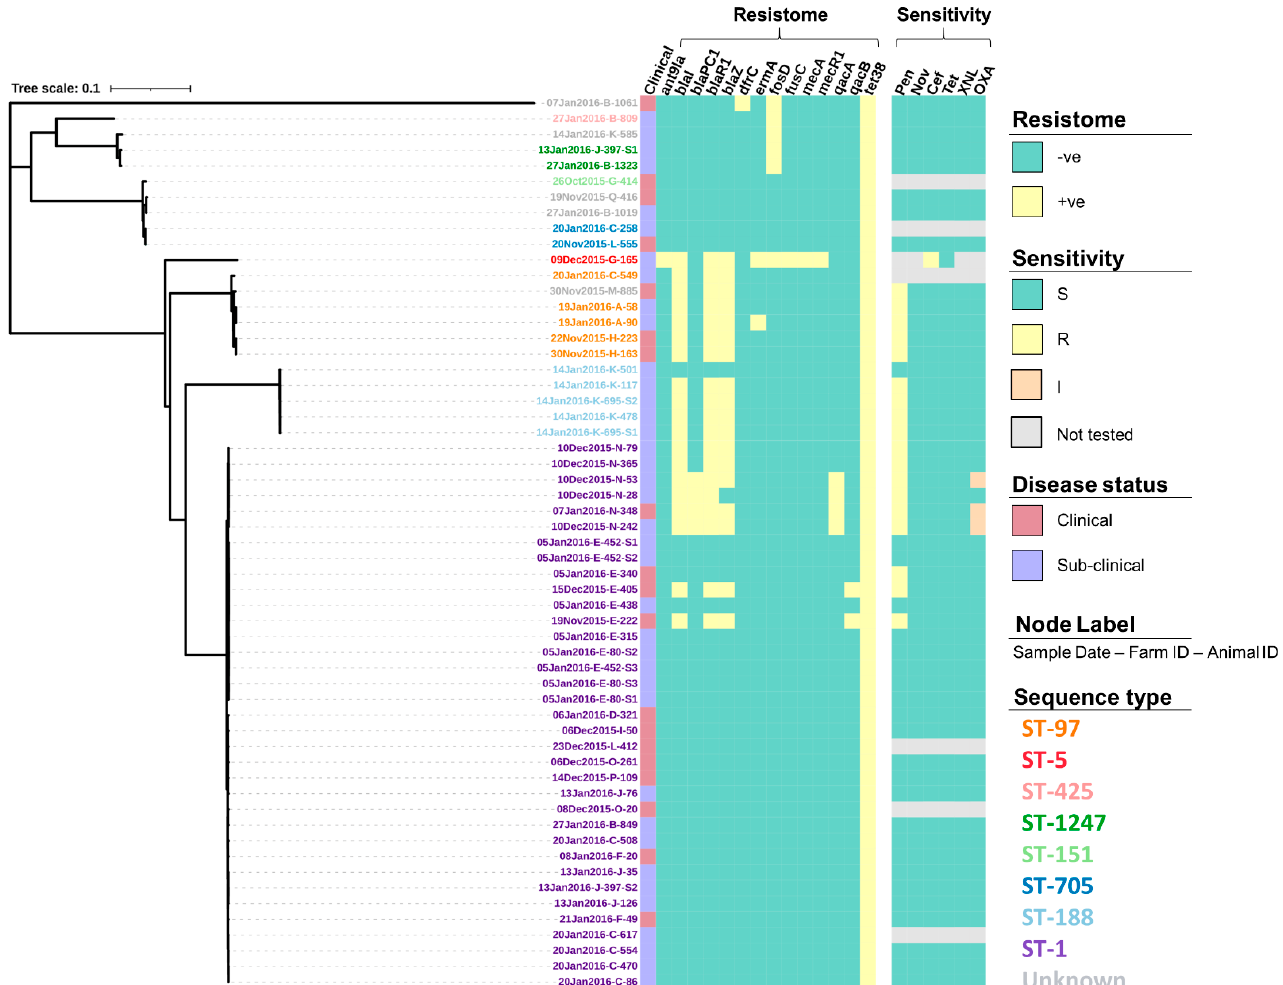
Figure 3. Resistance gene profiles (resistome) and the antimicrobial susceptibility profiles (sensitivity) of 57 S. aureus isolates presented alongside a maximum-likelihood tree generated from the core single nucleotide polymorphisms. Susceptibility was determined using a zone diffusion test following the procedures provided by the Clinical and Laboratory Standards Institute (CLSI) for penicillin (Pen), novobiocin (Nov), cefoxitin (Cef), tetracycline (Tet), ceftiofur (XNL), and oxacillin (OXA), with isolates being declared susceptible (S), intermediate (I) or resistant (R), based on CLSI recommendations. Isolate IDs identify the date the sample was collected (dd/mm/yyyy), the farm from which it was collected from (A–Q), and the animal ID number.